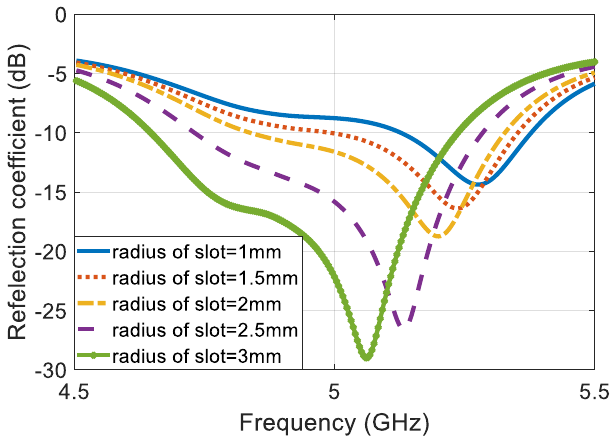
Figure 5: Reflection coefficient of the array for various radius of slots (spacers length =8 mm).